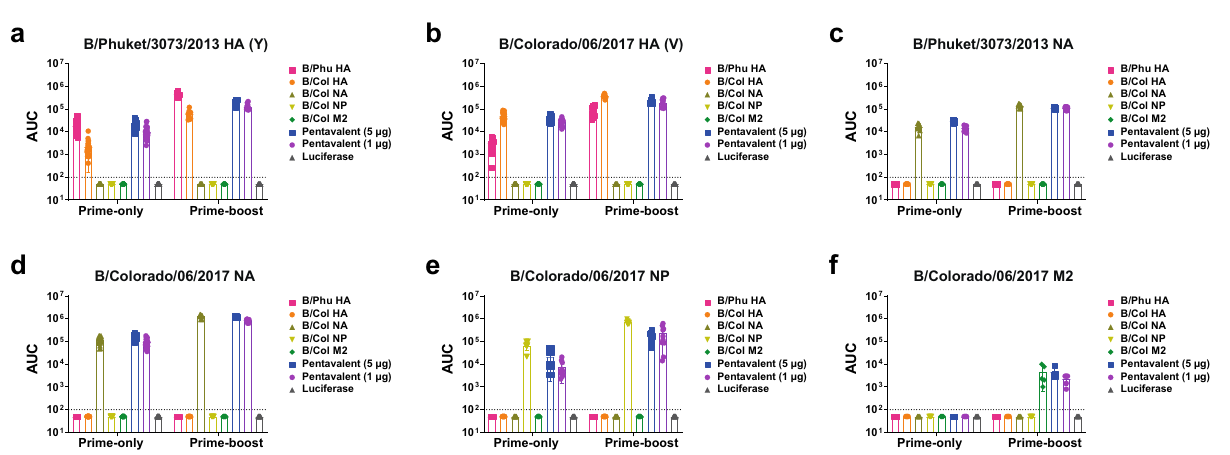
Fig. 3 | Serum reactivity to different IBV antigens. Mice were vaccinated with a prime only or prime-boost vaccination regimen (28days apart) I.D. with 5 μ g of monovalent mRNA-LNPs or with 5 μ g/antigen or 1 μ g/antigen of the pentavalent mRNA-LNP formulation. Control animals received 5 μ g of luciferase mRNA-LNP. Serawerecollectedonday28postprimeandpostboostandbindingofantibodies toin fl uenzaantigenswasmeasuredbyELISA.BindingofseraagainstB/Phuket/307/ 2013 HA ( n =25 prime-only samples, n =10 prime-boost samples). ( a ) B/Colorado/